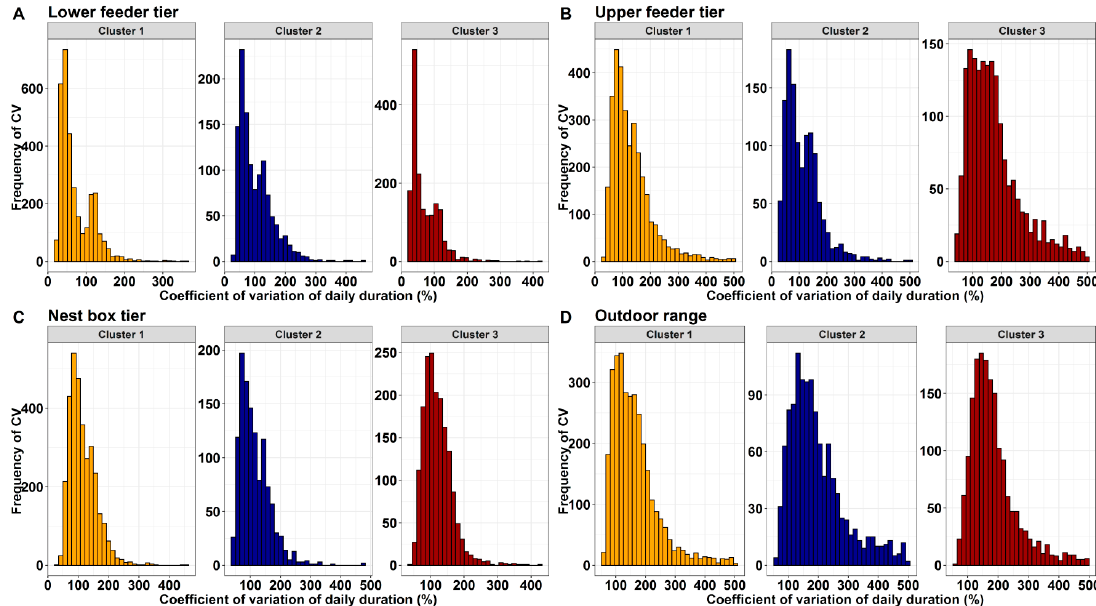
Figure 5. Frequency histograms of the CV for daily duration and number of visits to the range in cluster 1 (orange), 2 (dark blue), and 3 (dark red) for free-range laying hens based on the K-means cluster analysis for lower feeder zone ( A ), upper feeder zone ( B ), nest box ( C ) and outdoor range ( D ). Table 3. The descriptive statistics of the CV for the daily duration of the three clusters detected in commercial free-range flocks.